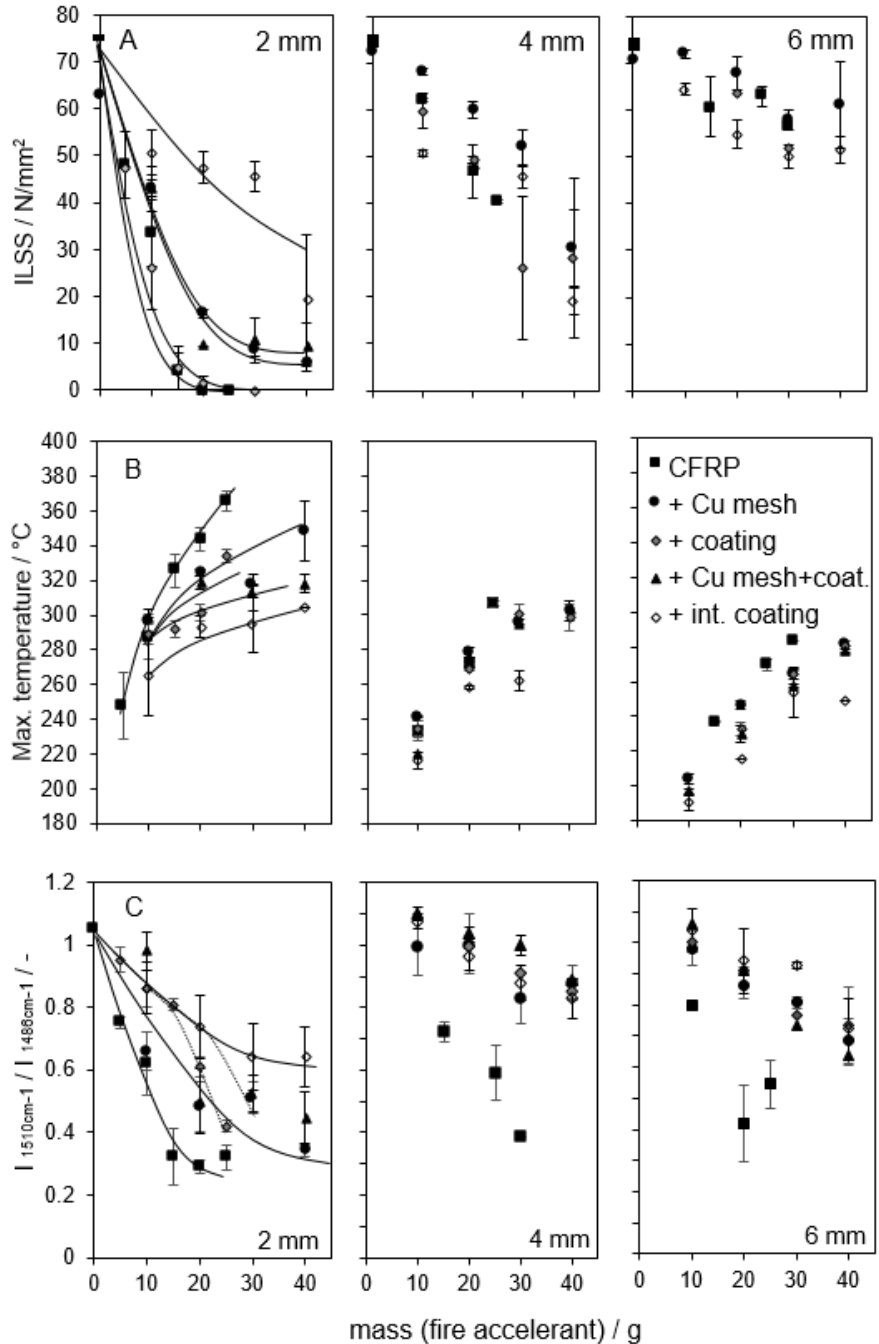
Figure 17. Results for 2, 4, and 6 mm thick 8552/IM7 samples with various protective measures after impact of various amounts of fire accelerants: ( A ) Minimum interlaminar shear strength (ILSS); ( B ) maximum temperatures at the center of the backside; ( C ) Minimum intensity ratios of bands characteristic for EP (1510 cm − 1 ) and PES (1486 cm − 1 ).